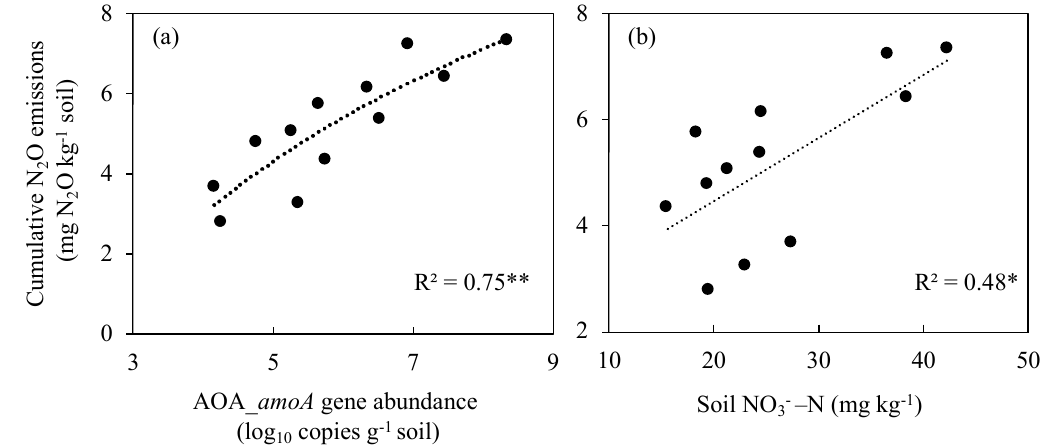
Figure 7. Correlation analysis of cumulative N 2 O emissions with AOA and soil NO 3 − –N: ( a ) between cumulative N 2 O emissions and AOA, n = 12; ( b ) between cumulative N 2 O emissions and soil NO 3 − -N, n = 12. For correlation analysis, R 2 values with asterisks * and ** denote r 2 < 0.05 and r 2 < 0.01, respectively.